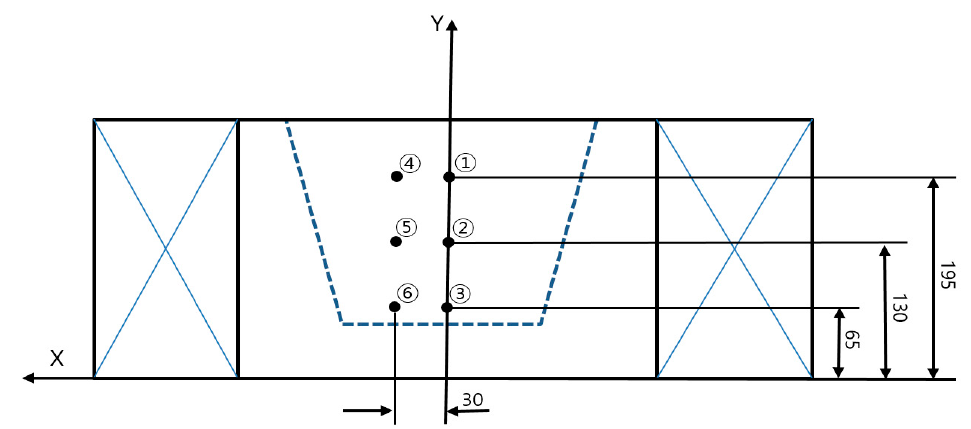
Figure 2. Crucibles cup shape and measurement position of electromagnets .